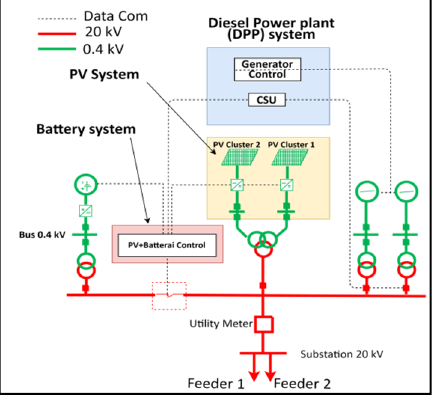
Figure 5. Line diagram of the system proposed with